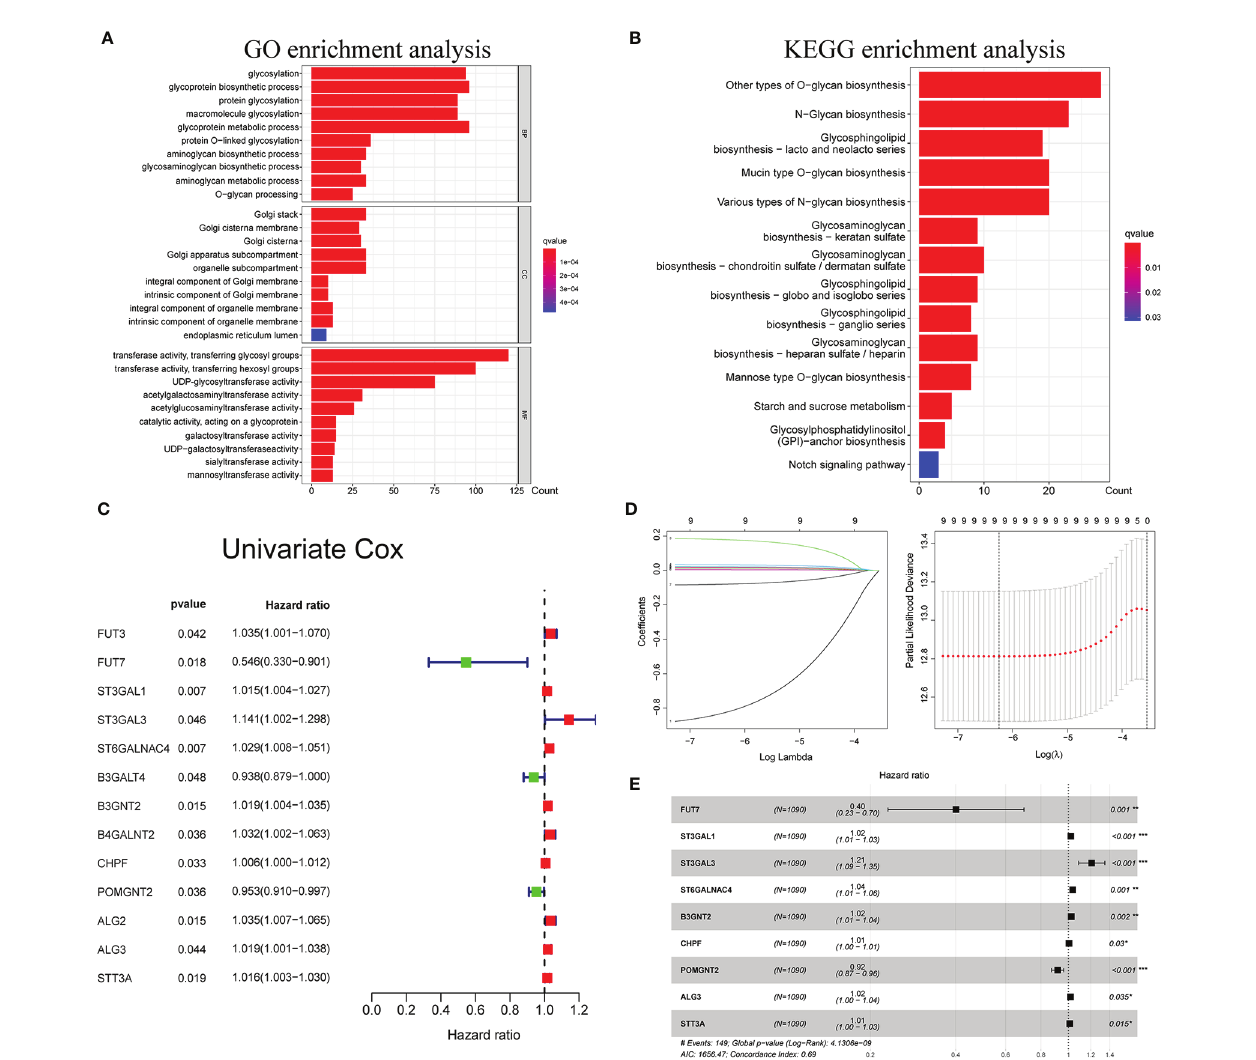
FIGURE 1 | Functional enrichment analysis of glycosyltransferase genes and construction of glyco-signature. Functional annotations of glycosyltransferase-associated DEGs were determined from GO (A) and KEGG (B) pathway analyses. (C) Univariate Cox regression analysis screened 13 glycosyltransferase genes that were related to the BC prognosis (p < 0.05). (D) Lasso coef fi cient pro fi les of the 13 prognosis-associated glycosyltransferase genes with non-zero coef fi cients validated by the optimal lambda. (E) Multivariate Cox regression analysis selected 9 glycosyltransferase genes to construct a risk signature. DEGs, differently expressed genes; GO, Gene Ontology; KEGG, Kyoto Encyclopedia of Genes and Genomes; BC, breast cancer. *p < 0.05, **p < 0.01, ***p <